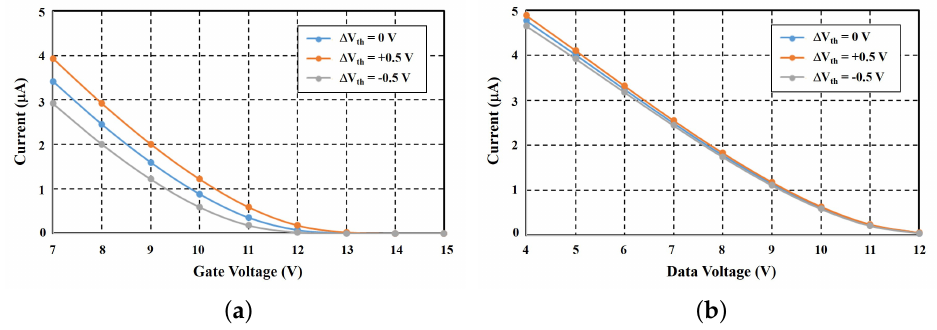
Figure 16. OLED currents over V th variation of ± 0.5 V: ( a ) without pixel compensation; and ( b ) with pixel